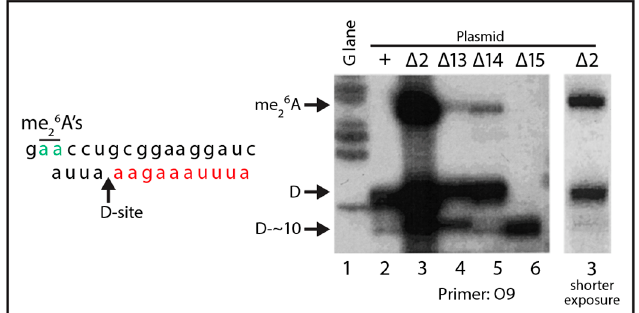
Figure 6. Mapping of 5 ′ ends at the D-site made by processing of pre-rRNA from wildtype and the indicated deletion mutants. Host ∆ rpa12 carrying the indicated derivatives of pDK16-tag was grown at 25° and shifted to 37° for 6 h. Total RNA was used for extension of primer O9 (Figure 1A). A G-lane made by dideoxy sequencing using pDK16 DNA and primer O9 is shown as markers. The blot on the right shows lane 3 from a shorter exposure of the blot in lanes 1–6. The nucleotide sequence around the D site is shown on the left to facilitate the interpretation of the G-lane as marker. Red: ITS1 nucleotides; black: 18S rRNA nucleotides; green: the dimethylated A residues.